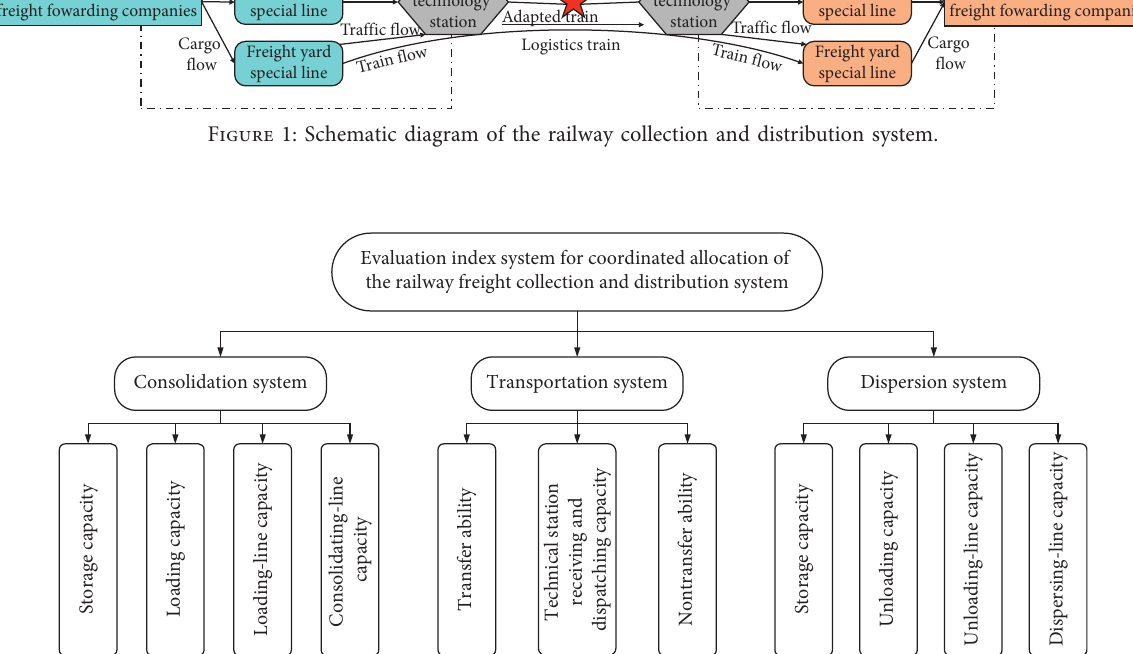
Figure 2: Evaluation index system for coordinated allocation of the railway freight collection and distribution